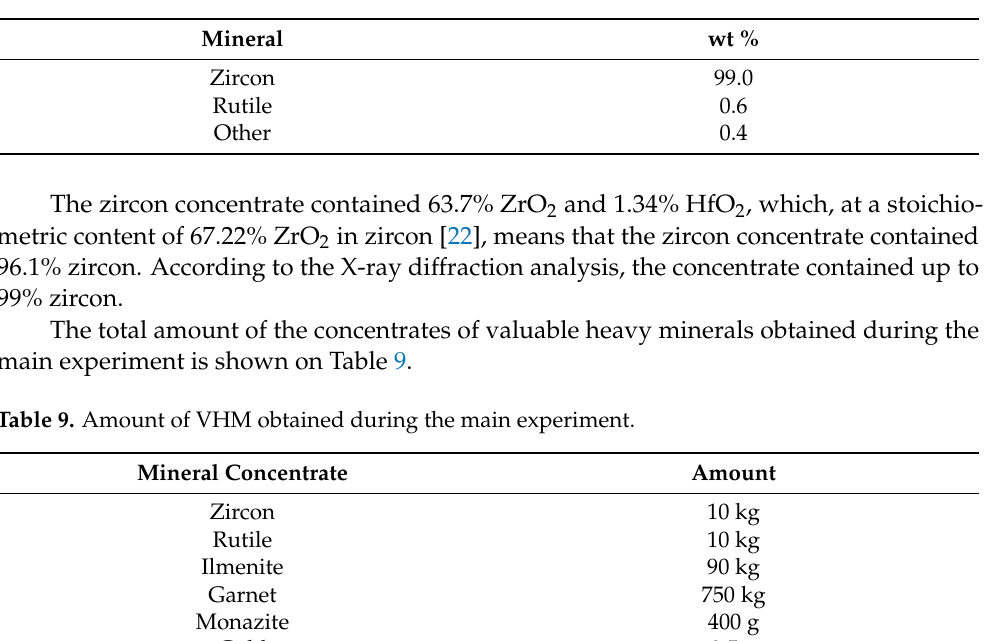
Table 8. Mineralogical composition of zircon concentrate.